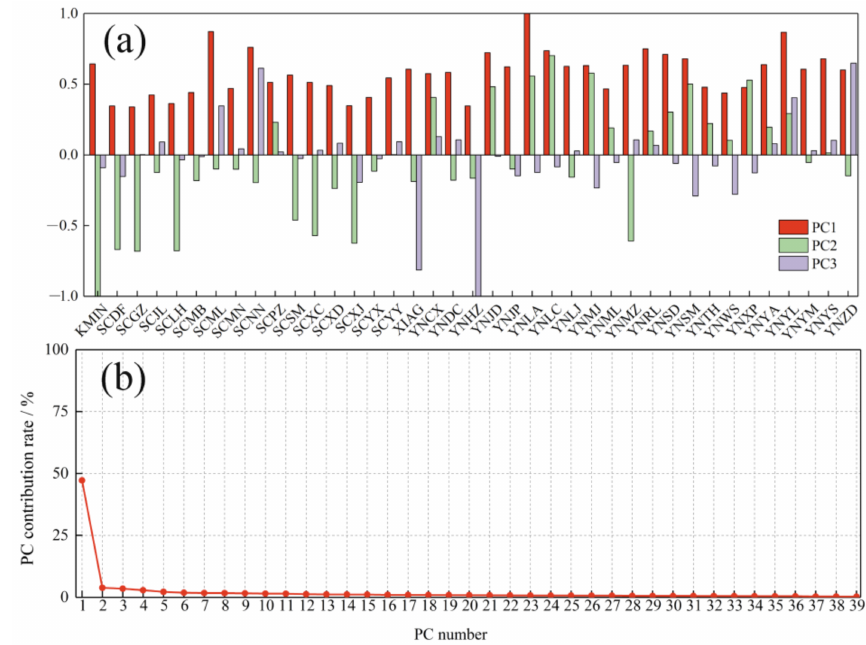
Figure 6. ( a ) The normalized spatial eigenvectors of the first three principal components and ( b ) contribution rate of all principal component